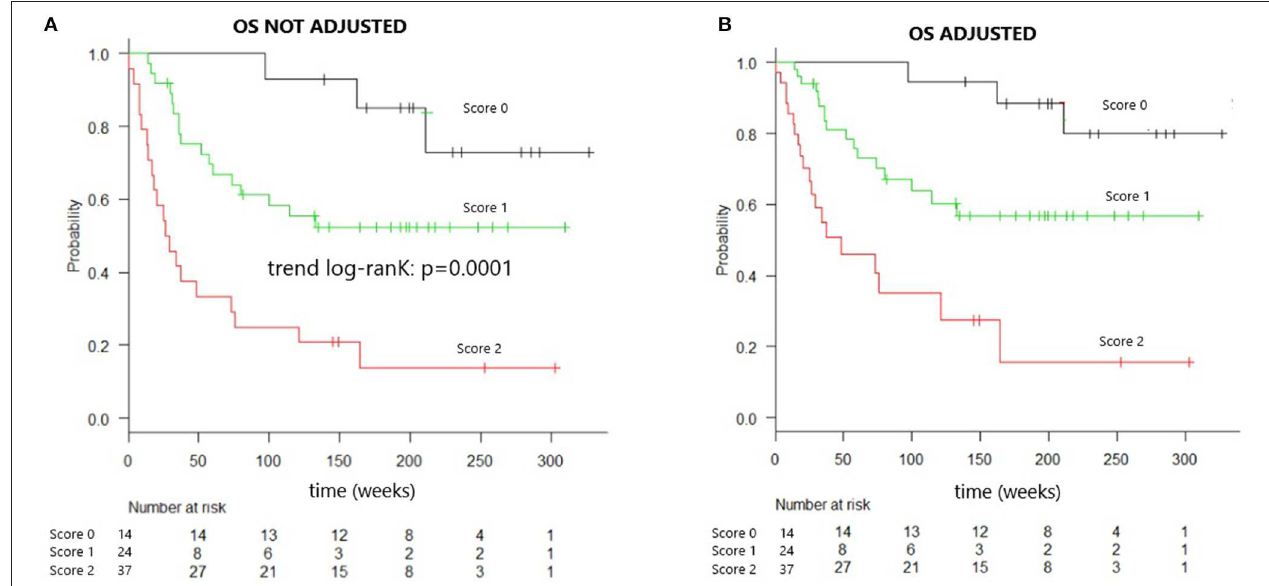
FIGURE 1 | Overall survival of patients identified by combined cytokines score. (A) Overall survival curve of patients identified by combined cytokines score. Overall survival at 2 years is 95% for patients “score 0,” 65% for “score 1” patients, 30% for “score 2” patients (trend log-rank: p = 0.0001), median OS in score 2 patients is 26 weeks. (B) Overall survival curve of patients identified by combined cytokines score and adjusted for the effect of diagnosis, GVHD prophylaxis, and HSC source.